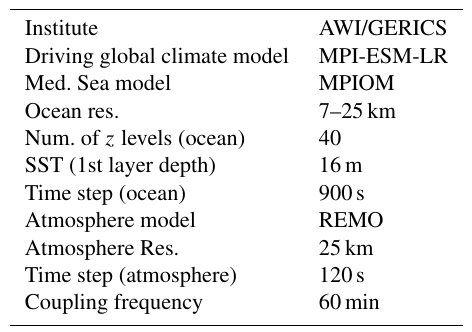
Table 1. Characteristics of ROM atmosphere–ocean regionally coupled model used in this study. Modified from Darmaraki et al. (2019). For details see Sein et al.